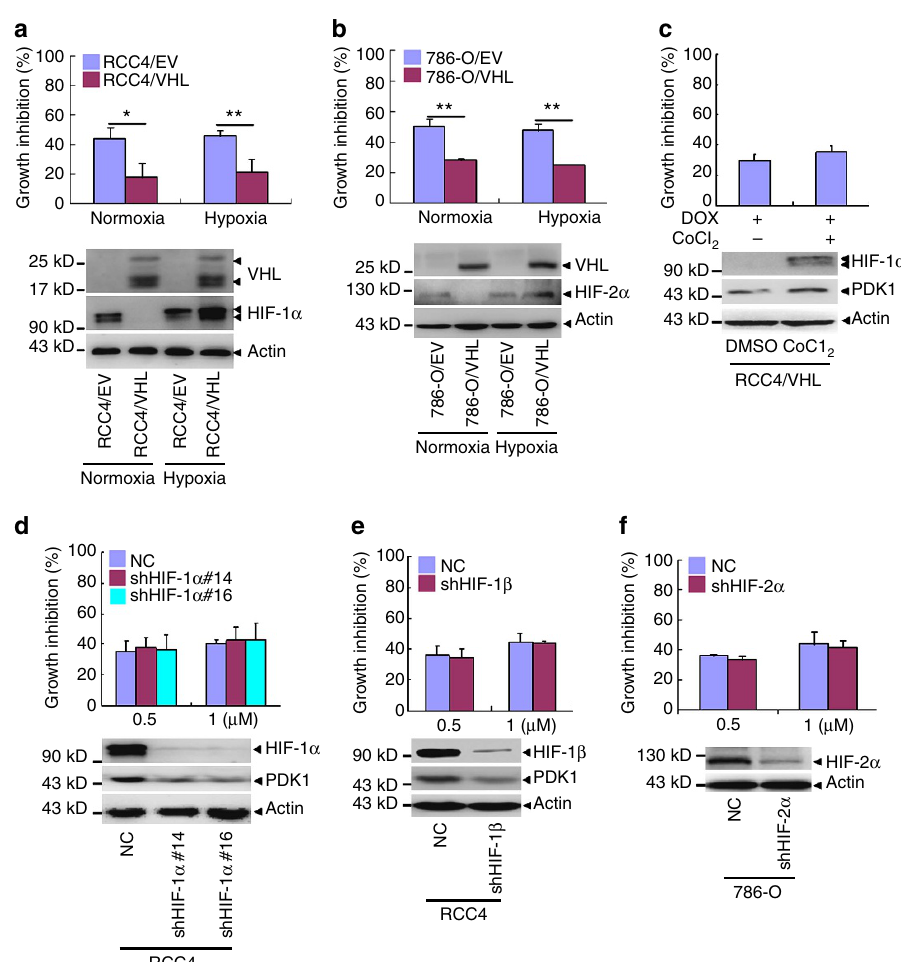
Figure 3 | HIFs is not involved in cytotoxicity of anthracyclines in ccRCC cells. ( a – f ) The cell growth inhibition rates of indicated cells were detected by CCK-8 (top). The indicated proteins were detected by western blot (bottom). RCC4/EV and RCC4/VHL cells ( a ), or 786-O/EV and 786-O/VHL cells ( b ) were incubated in normoxia or hypoxia for 24h followed by 1 m M doxorubicin treatment for 24h. ( c ) RCC4/VHL cells were treated by 200 m M CoCl 2 for 12h and 0.1% DMSO as control, then treated with 1 m M doxorubicin for 48h. ( d – f ) The indicated cells were treated with 0.5 or 1 m M doxorubicin for 24h. ( d ) RCC4 cells were stably transfected with shRNAs against HIF-1 a ( a 14 and a 16). ( e ) HIF-1 b was silenced by shRNAs in RCC4 cells. ( f ) 786-O cells were stably transfected with shRNAs against HIF-2 a . Columns, means of three independent experiments with triplicate samples; bars, s.d. (* P o 0.05, ** P o 0.01 for t cytotoxicity of anthracyclines in VHL-deficient ccRCC cells, the ALDH2 protein levels were also not affected by HIF-1 a and HIF-2 a silencing in RCC4 cells and 786-O cells (Fig. 6e,f). These